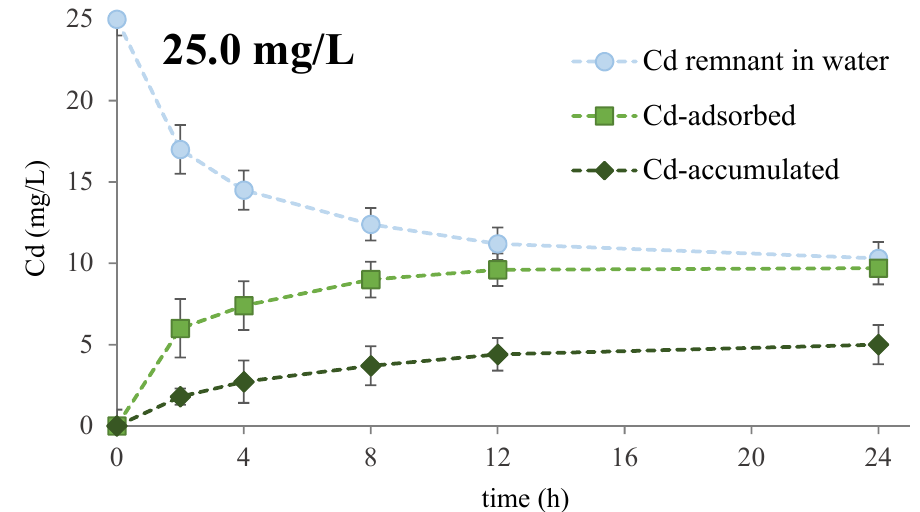
Figure 1. Metal removal ( ● ), adsorption ( ■ ), and intracellular accumulation ( ♦ ) kinetics in living Oscillatoria sp. during 24-h exposure at 5.0 or 25 mg/L of Cd. Data are mean ± SD of three independent experiments ( n = 3).